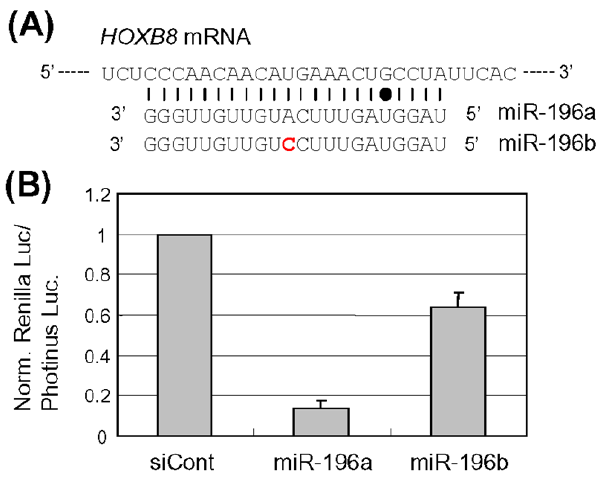
Figure 5. Different knockdown potencies against HOXB8 between miR-196a and miR-196b . (A) Nucleotide sequences of HOXB8 mRNA, miR-196a and miR-196b. The HOXB8 mRNA sequence, which is nearly complementary to miR-196a, together with mature miR- 196a and miR-196b are aligned. Perfect base-pairing and G:U wobble base-pairing are indicated by the horizontal bars and dot, respectively. The mismatched base in miR-196b is indicated in red. (B) Effects of miR- 196a and miR-196b on gene silencing against HOXB8 . The miR-196a and miR-196b duplexes were chemically synthesized, as described previ- ously [31]. The synthetic miRNA duplexes, together with a reporter plasmid carrying a part of the HOXB8 gene (see Materials and Methods), were cotransfected into HeLa cells and the expression of reporter gene was examined. Ratios of normalized target ( Renilla ) luciferase activity to control ( Photinus ) luciferase activity are shown. Data are averages of at least three independent experiments. Error bars represent standard